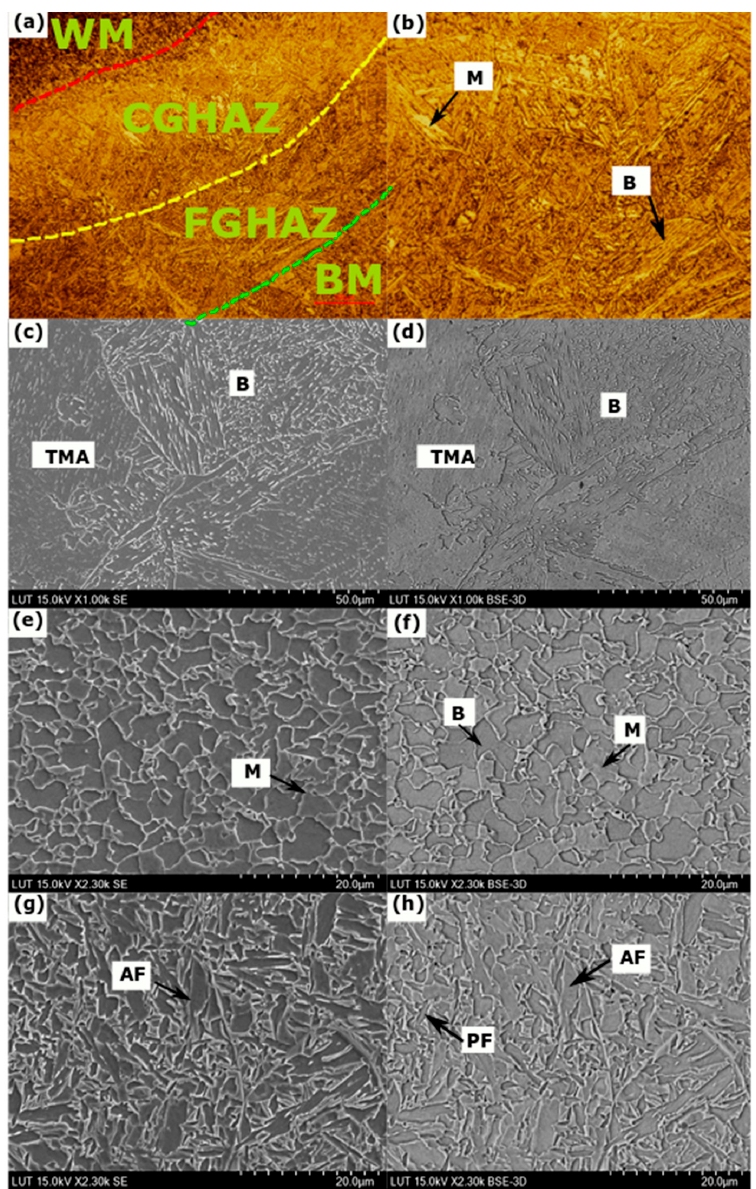
Figure 9. OM and SEM micrographs showing the microstructures of S960QC steel in the different sub-zones of the welded joint: ( a ) OM image showing the different sub-zones of the welded joint, ( b ) OM image of the CGHAZ of S960QC, ( c – d ) SEM image of CGHAZ using a resolution of 20 µm, ( e – f ) SEM image of the FGHAZ of S700MC, and ( g – h ) SEM image of the weld metal. The different phases identified by the SEM images using a resolution of 20 µm are shown in Figure 9c,d for the CGHAZ, Figure 9e,f for the FGHAZ, and Figure 9g,h for the WM. After the GMA